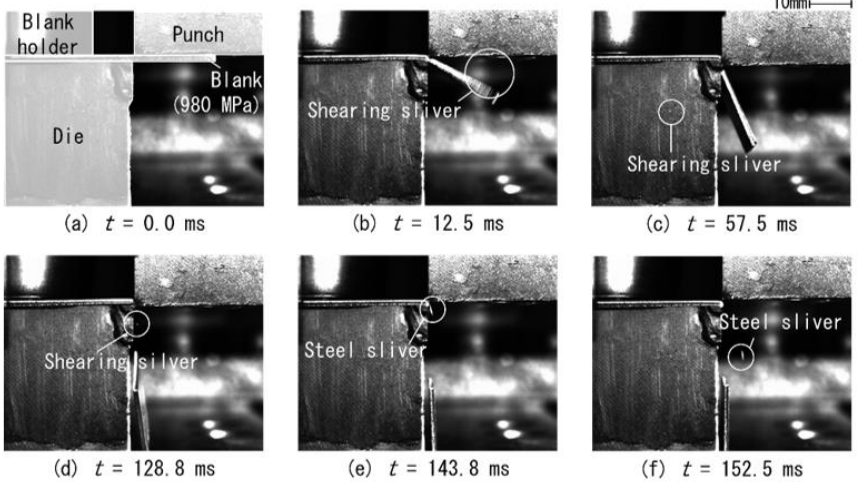
Figure 9. Behavior of shearing slivers at 980 MPa steel sheet: ( a ) start of shearing, ( b ) end of shearing,